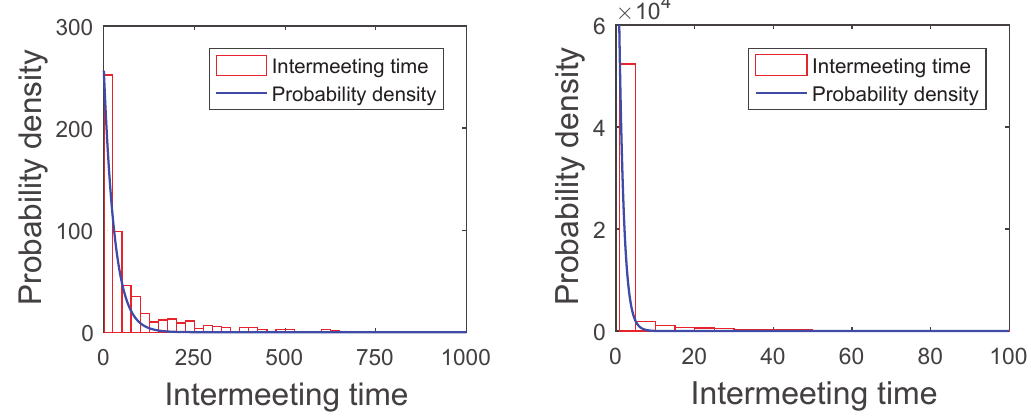
Figure 7. Epfl trace set.